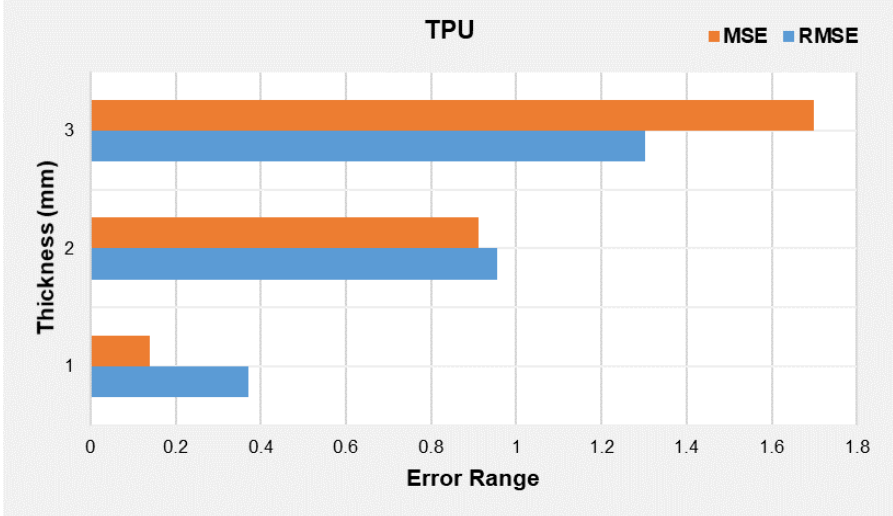
Figure 18. Thickness versus error ranges for MSE and RMSE for TPU beam.